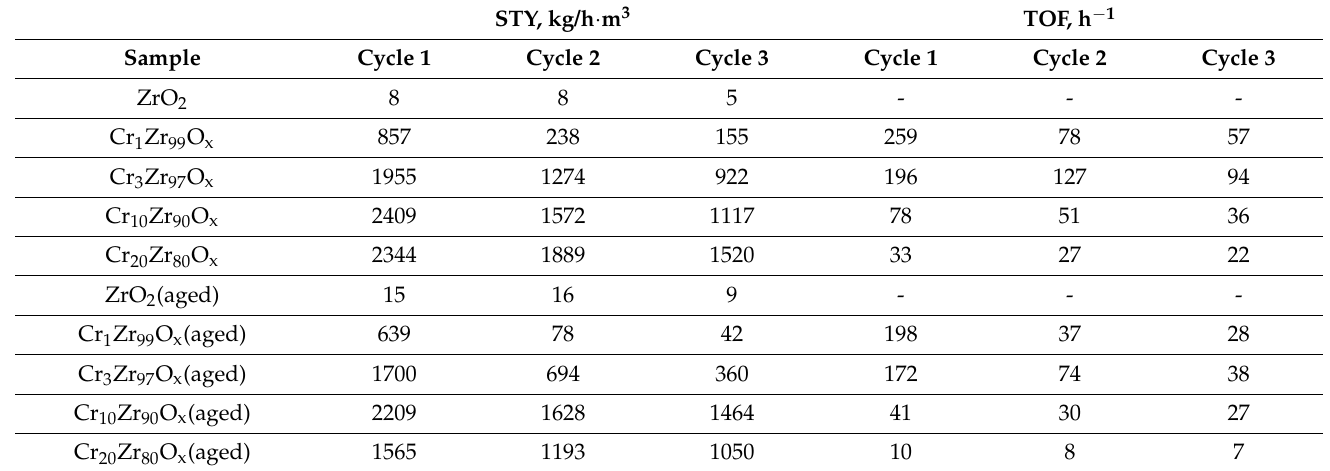
Table 4. STY and TOF for obtained sample during three